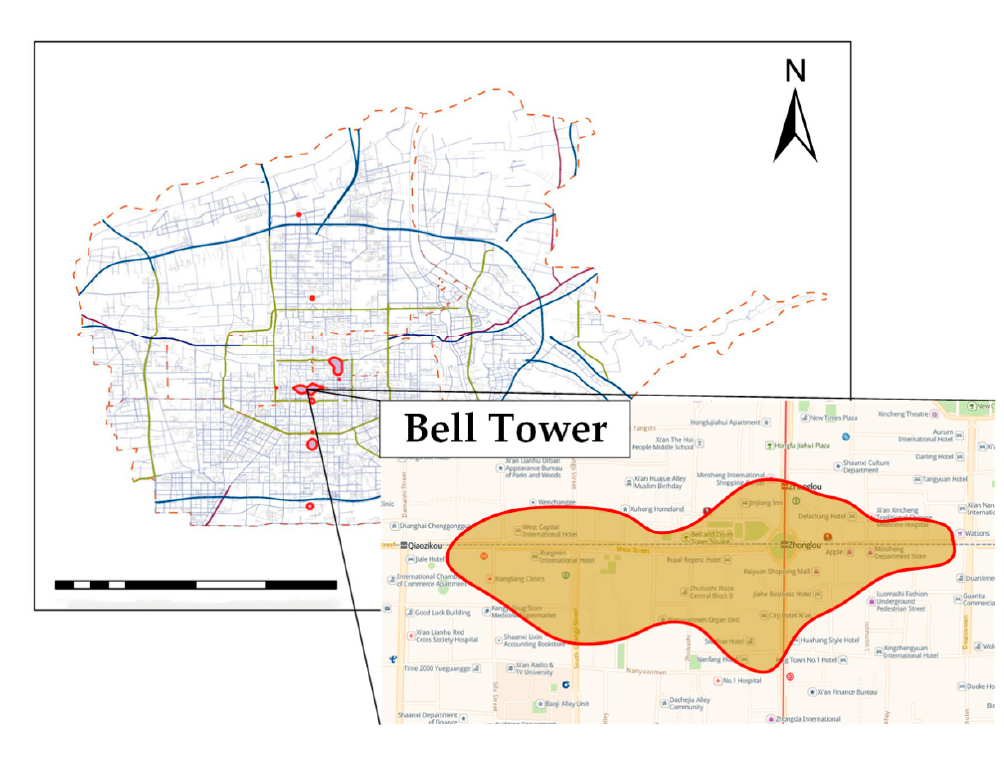
Figure 3. Research scope in the Bell Tower area.